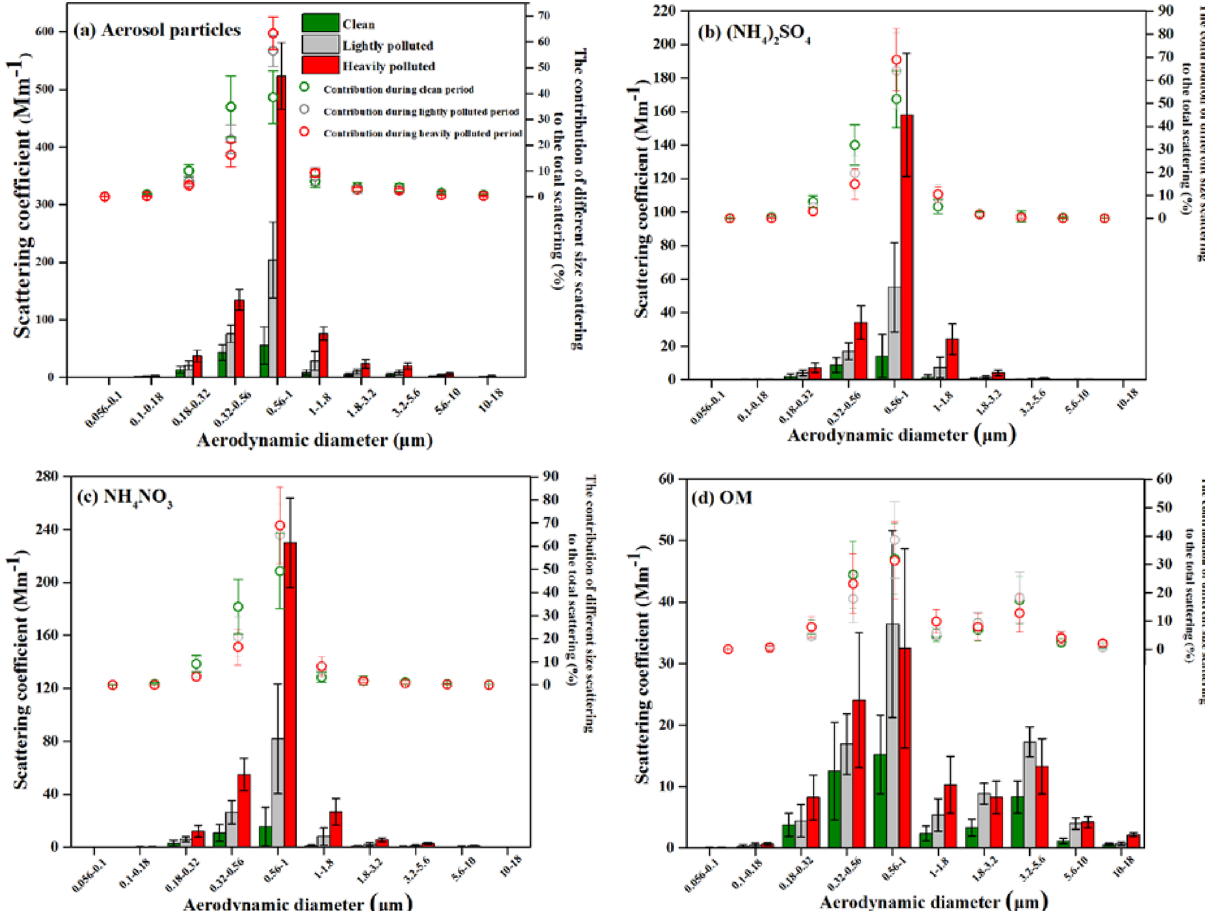
Figure 5. The size distribution of scattering coefficients of aerosol particles (a) , ( NH 4 ) 2 SO 4 (b) , NH 4 NO 3 (c) and OM (d) under different pollution levels. The contributions of particles with different sizes to the total scattering coefficient are indicated in the panels as well.